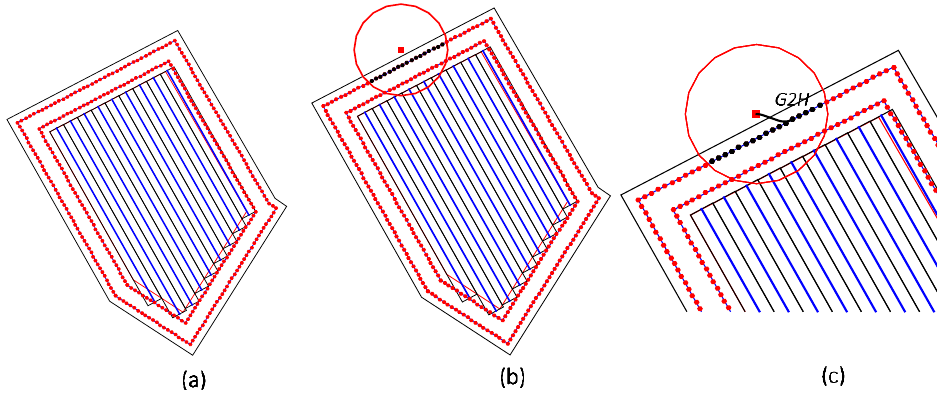
Figure 4. Illustration of procedures of generating gate to headland connector: ( a ) densify headland pass based on given length (l); ( b ) generate a circle centered at gate E with radius t; ( c ) generated G2H connector.